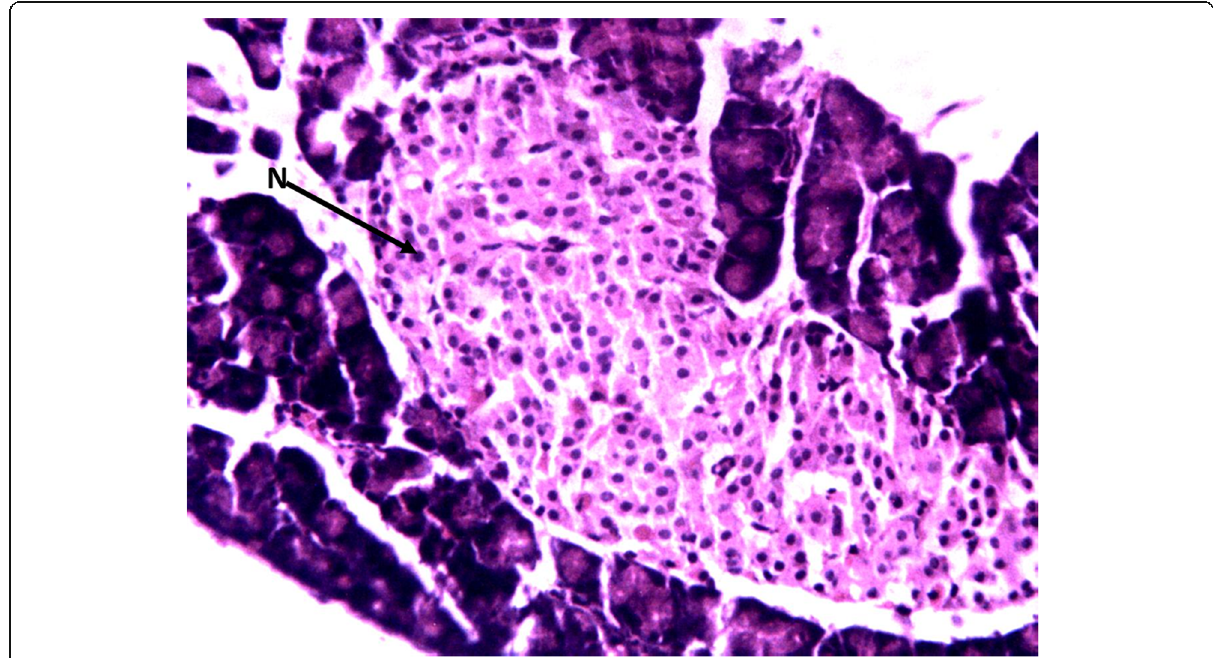
Fig. 1 Histology of the pancreas section stained with hematoxylin and eosin in the normal control group, × 250. N, normal pancreatic islet cells